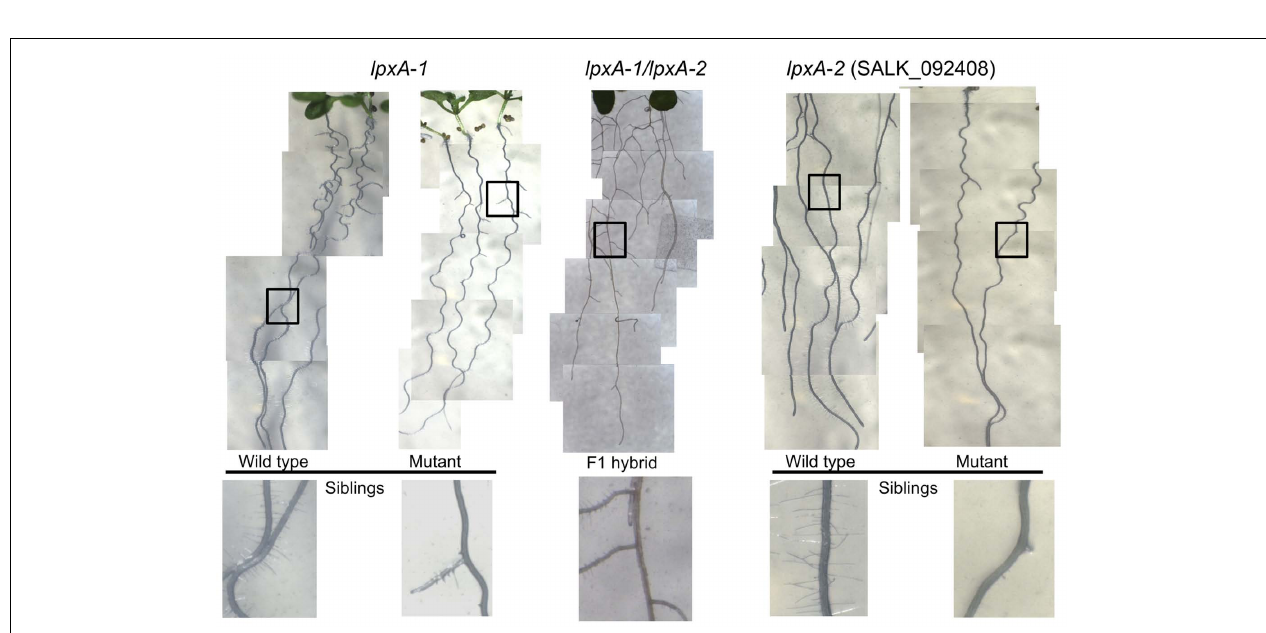
FIGURE 4 | Hierarchical cluster diagram of mutant alleles from Experiment 3 (E3). The dissimilarity between a pair of genes was computed from the mutant metabolomes using a variance-weighted Manhattan distance measure described in the Section “Materials and